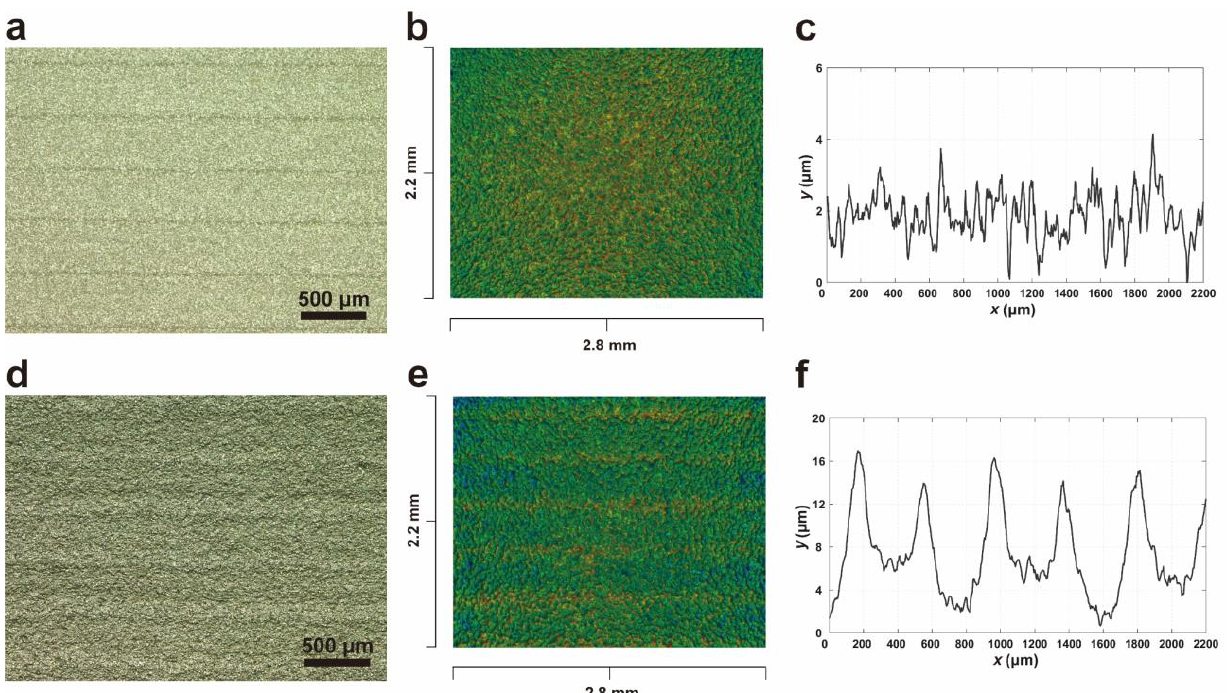
Figure 5. ( a ) Optical image of the layer surface before curing. ( b ) White light interference image of the layer surface before curing. ( c ) the corresponding cross-sectional profiles of ( b ). ( d ) Optical image of the layer surface after curing. ( e ) White light interference image of the layer surface after curing. ( f ) the corresponding cross-sectional profiles of ( e ).